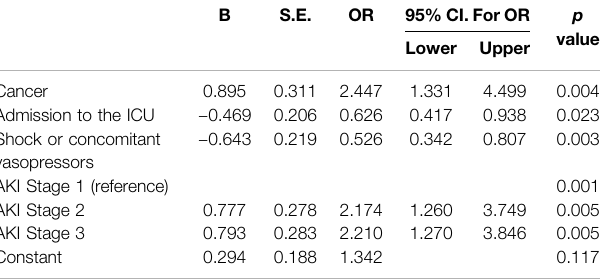
TABLE7| MultivariableLogisticRegressionofFactorsforfullrenalrecoveryofVA- AKI